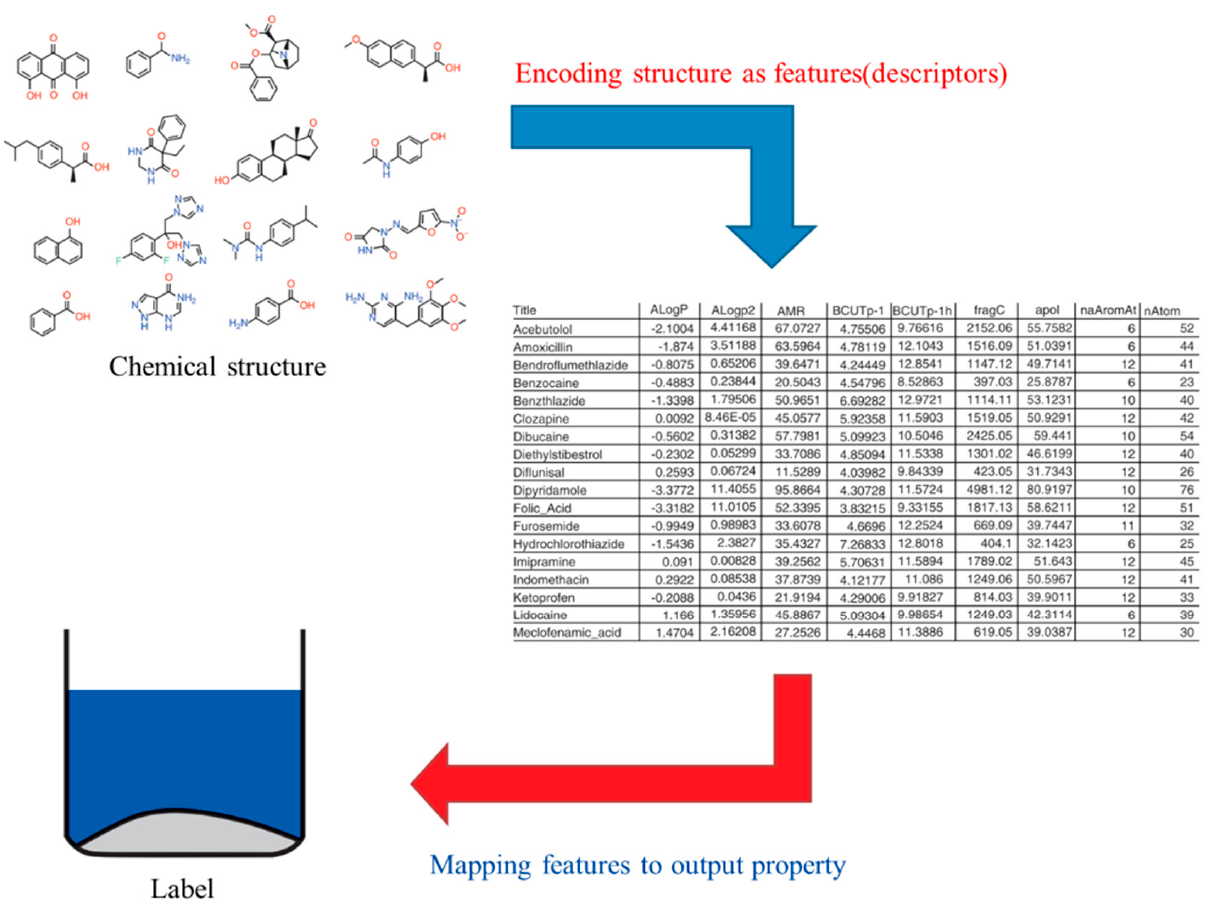
Figure 3. Conceive chemoinformatics as a two-part problem: encoding chemical structure as features and mapping the parts to the output property. The second of these is most often the province of ML. Revised from Reference [56] with permission from John Wiley and Sons.